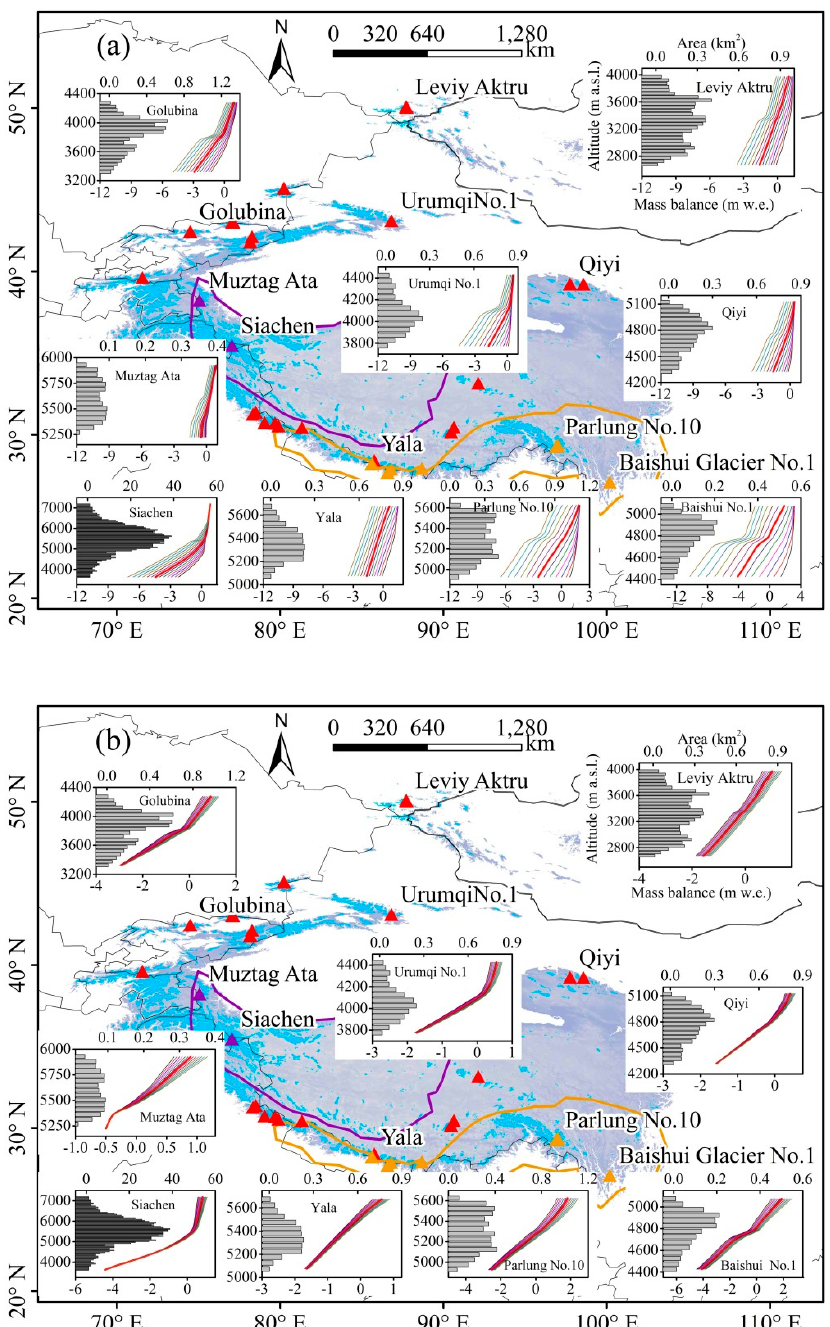
Figure 5. Sensitivity of mass balance (m w.e. year − 1 ) to ( a ) temperature and ( b ) precipitation change versus elevation for the selected subset of nine glaciers.